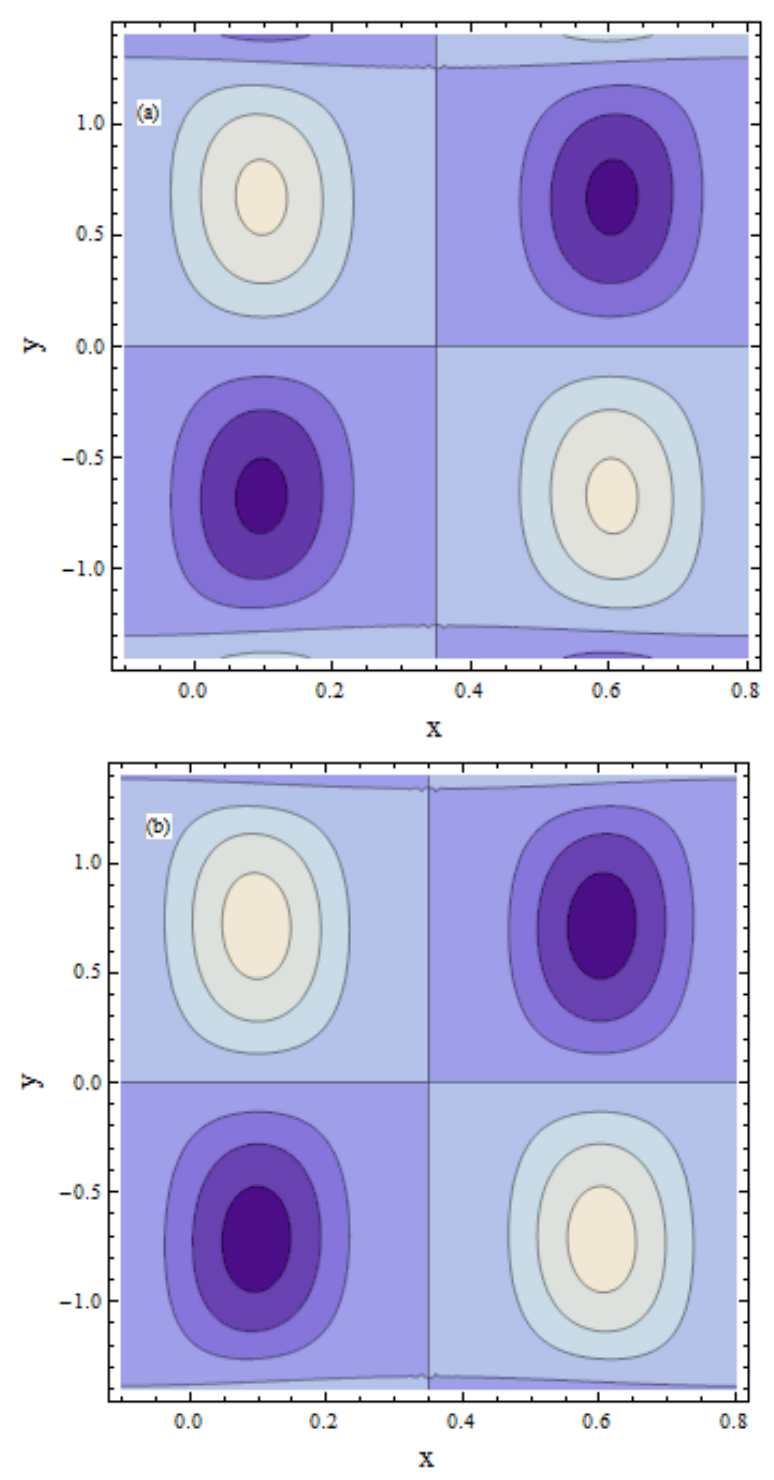
Figure 23. 𝜓 variation when ( a ) We = 0.1 and ( b ) We = 0.2.